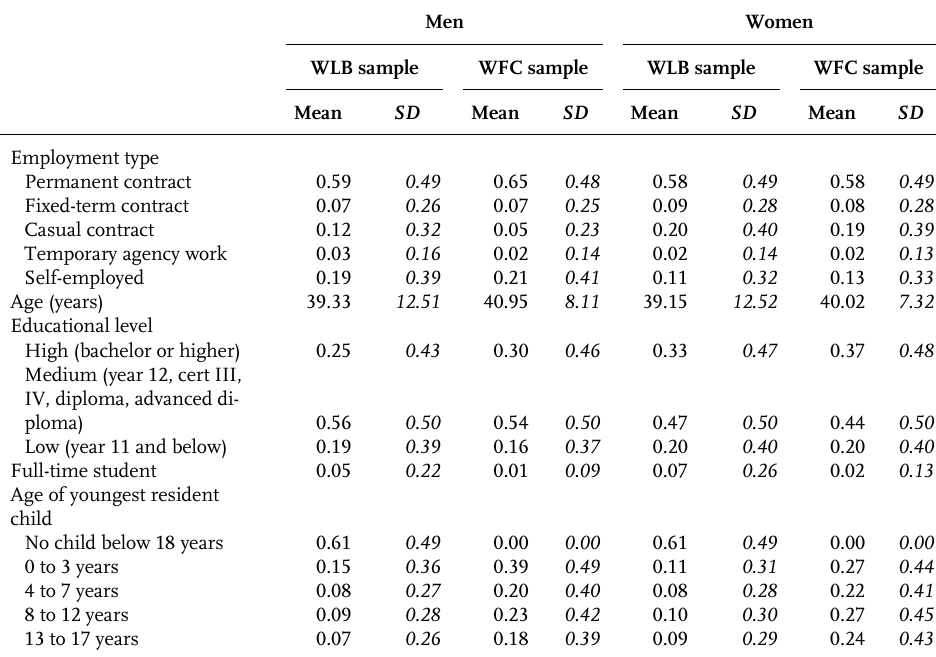
Table 1 : Summary statistics for analysis samples Men